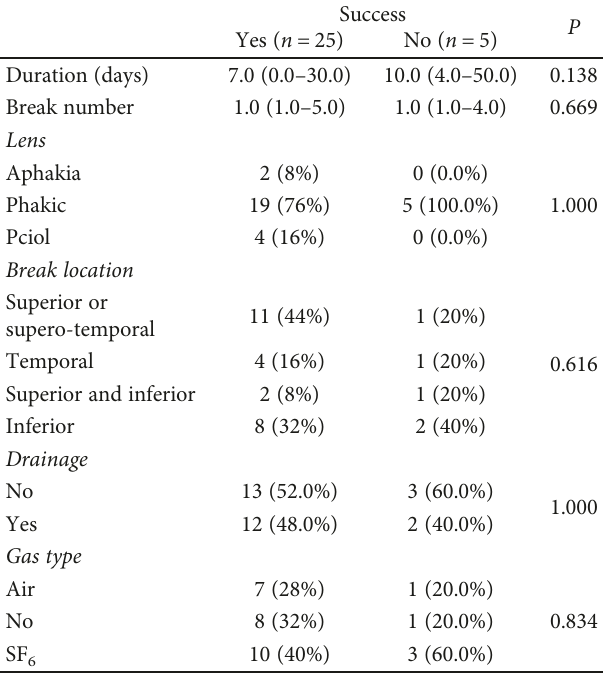
Table 4: Relation between anatomical success and periopertaive